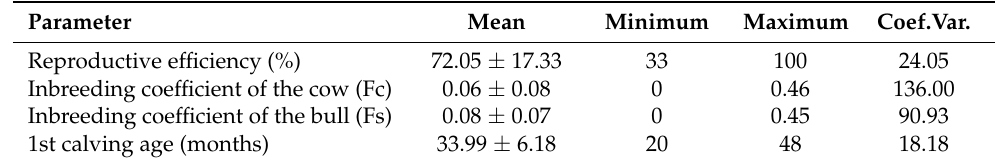
Table 1. Descriptive statistics for input data.